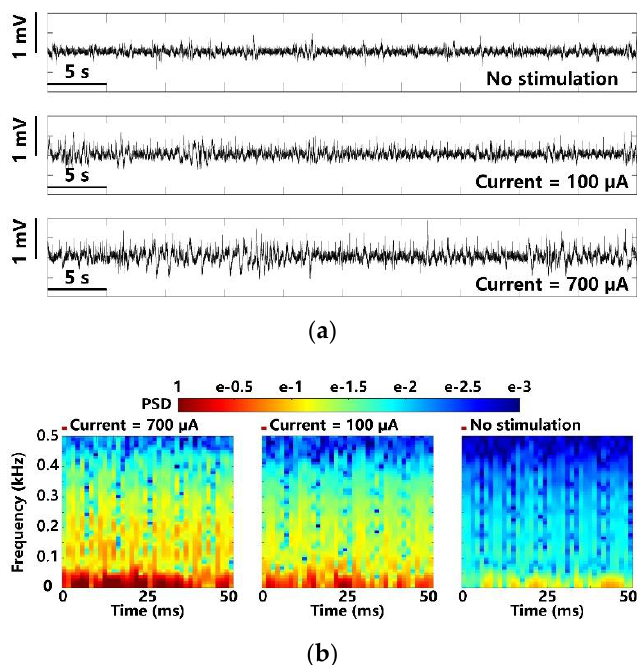
Figure 15. LFP analysis in terms of ( a ) amplitude variation and ( b ) normalized PSD with maximum and minimum electrical stimulation.